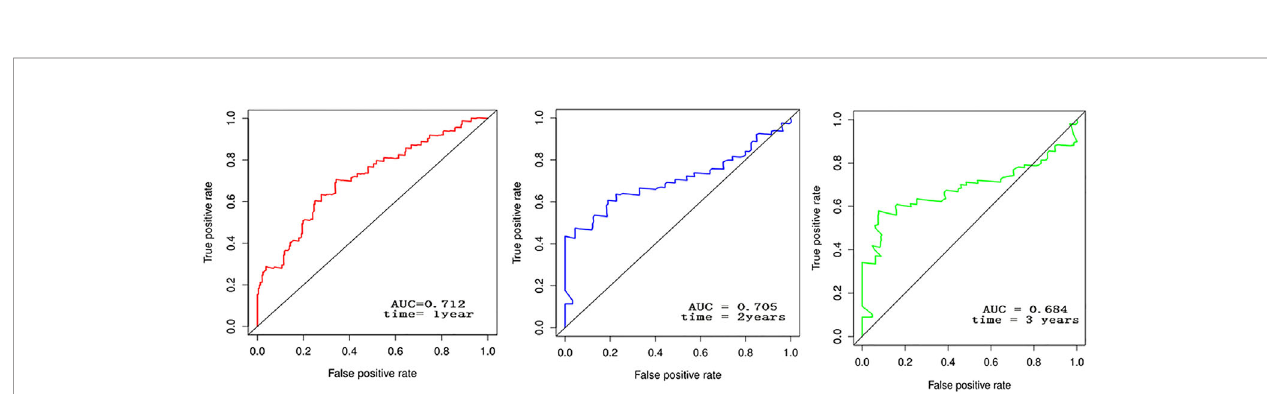
FIGURE 8 | The AUC corresponding to 1, 2, and 3 years of CXCR signature using K-M